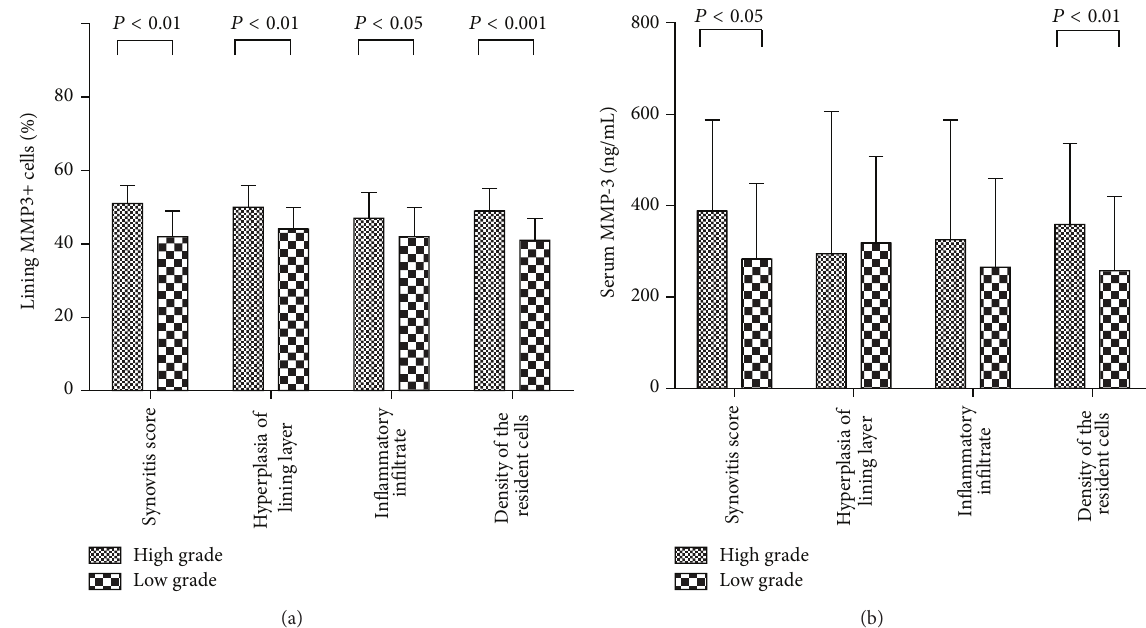
Figure 2: Synovial (a) and serum (b) MMP-3 expression between high and low grade groups of synovitis score or subscore.